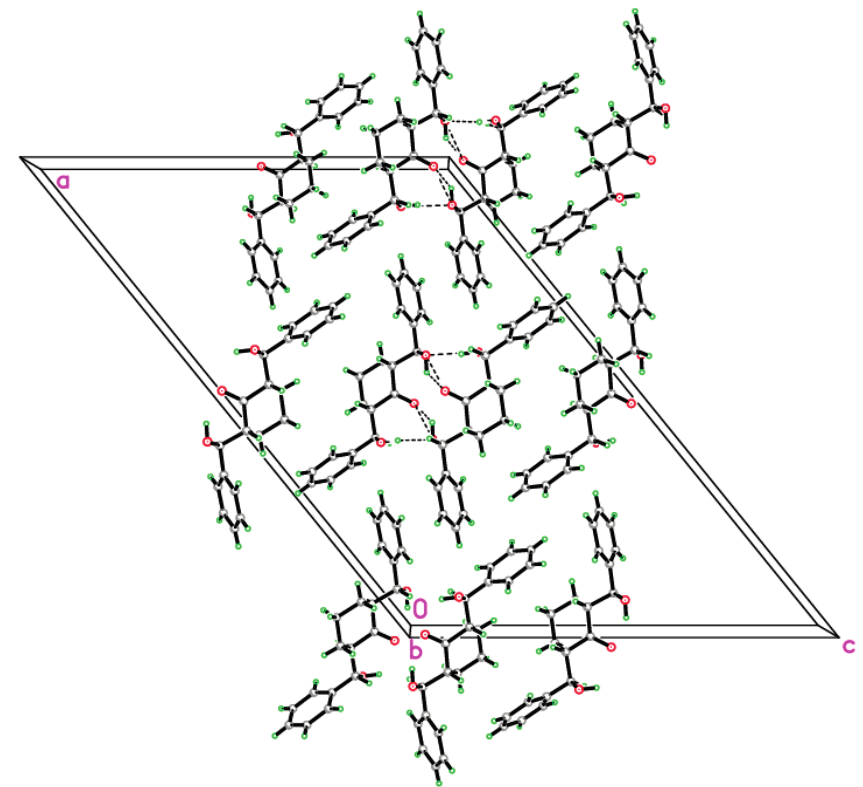
Figure 3. Crystal packing showing intermolecular C–H···O and N–H···O hydrogen bonds as dashed